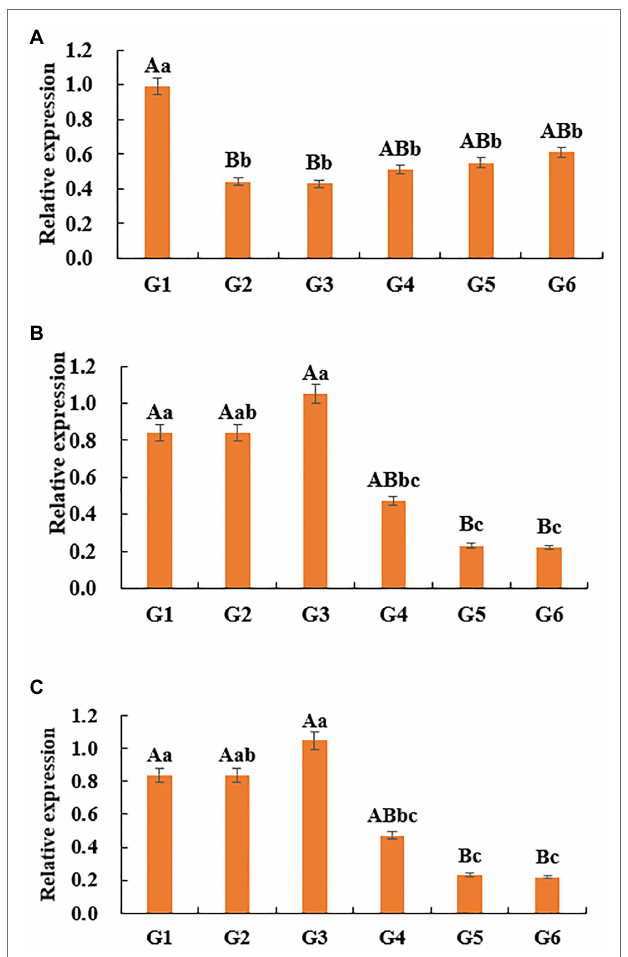
FIGURE 7 | Relative expression of DNMTs genes in skin tissues of Super Merino sheep. (A) The relative expression of DNMT1 gene. (B) The relative expression of DNMT3a gene. (C) The relative expression of DNMT3b gene. Different lowercase letters indicate significant difference ( p < 0.05), and different uppercase letters indicate extremely significant difference ( p < 0.01), the same letter expressed surprise was not significant ( p > 0.05).